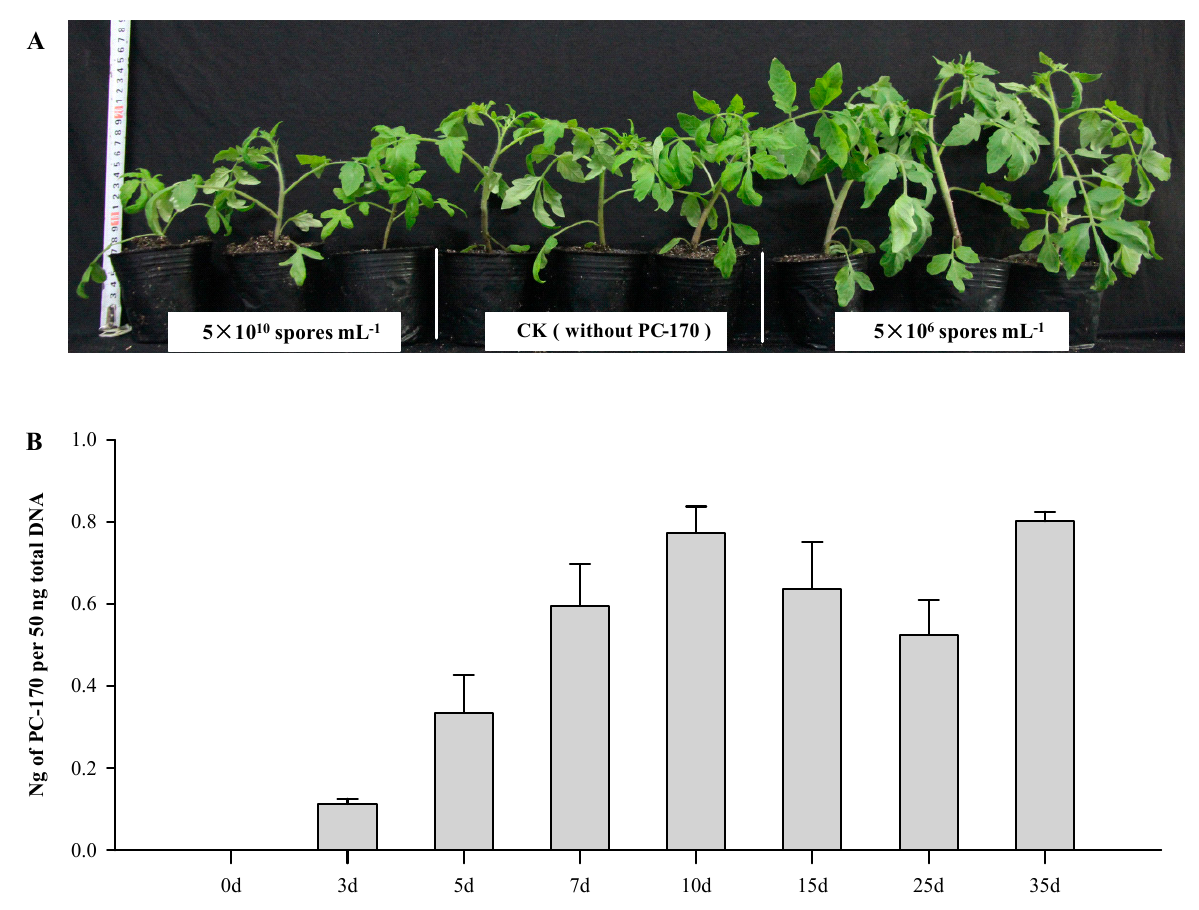
Figure 1. Pochonia chlamydosporia PC-170 colonizes tomato roots. ( A ) Tomato growth under different PC-170 spore concentrations. ( B ) The root colonization is expressed as the ratio of fungal DNA biomass per 50 ng of total root DNA. Each value is the mean ± SE of three biological samples with three technical replicates each.